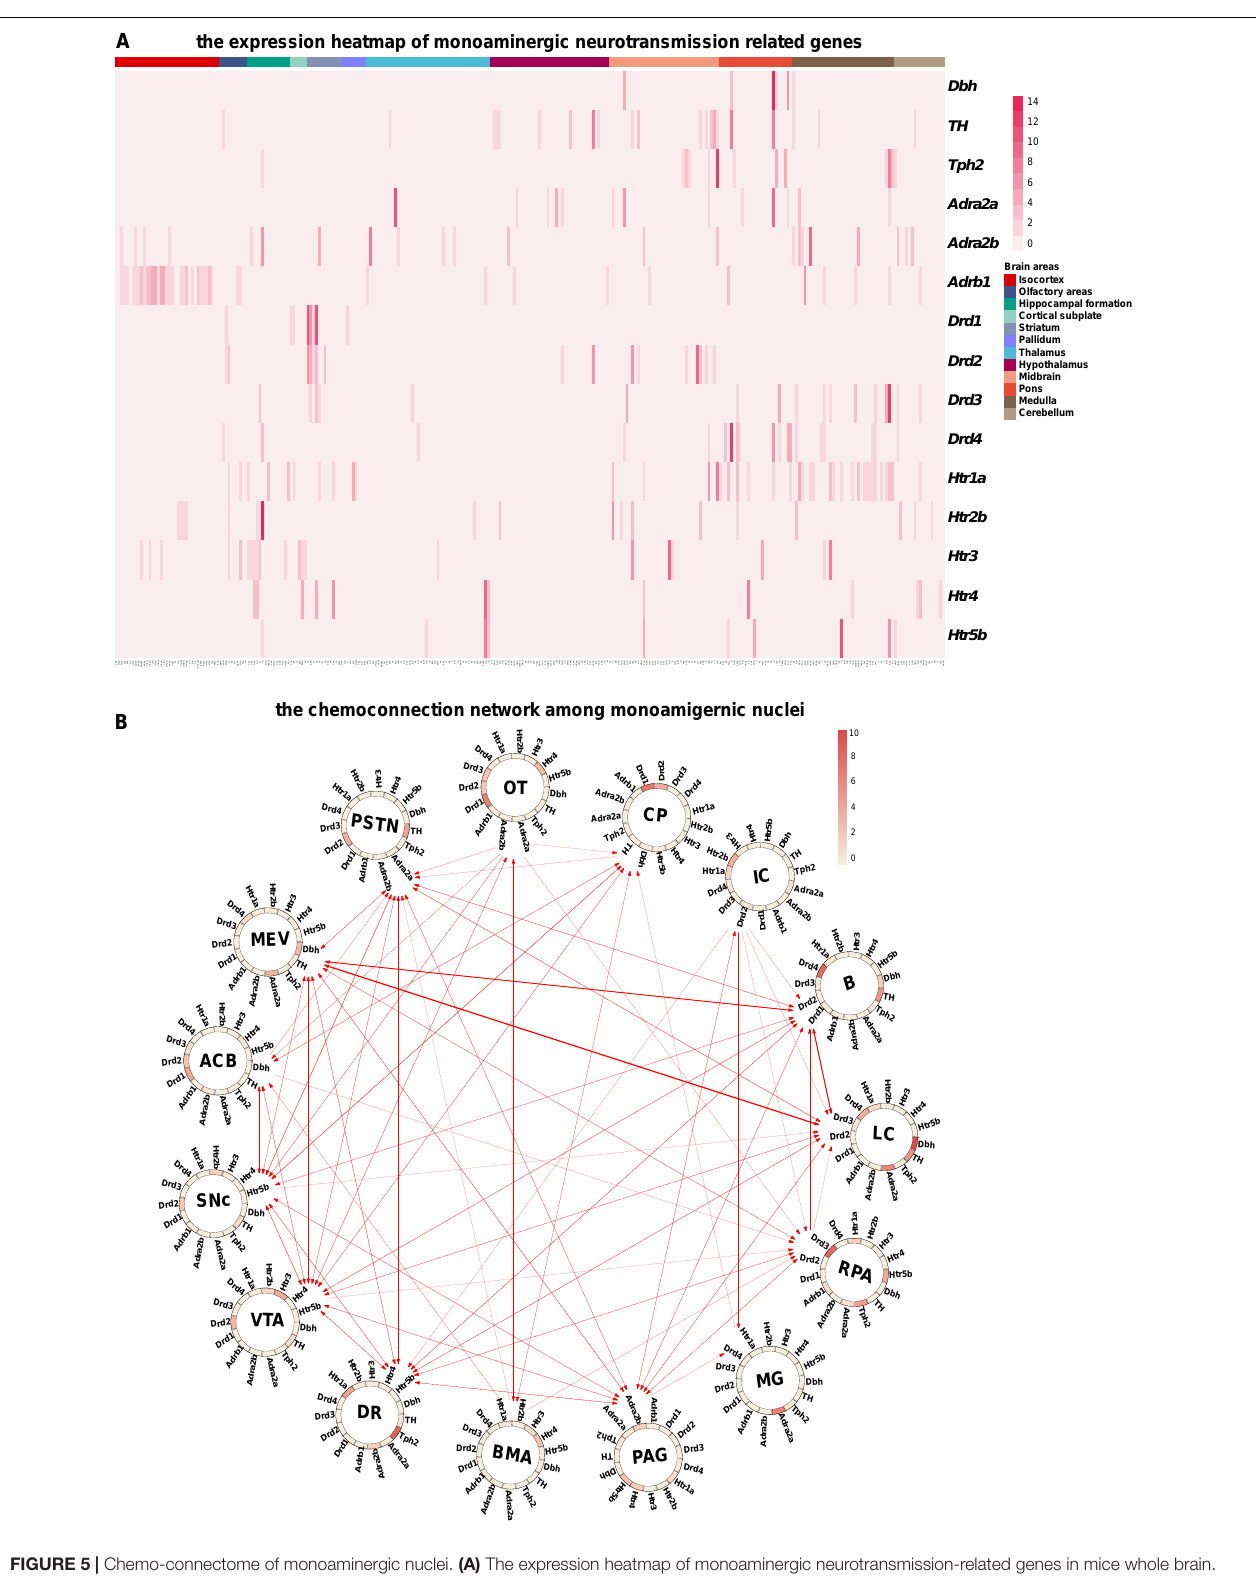
FIGURE 5 | Chemo-connectome of monoaminergic nuclei. (A) The expression heatmap of monoaminergic neurotransmission-related genes in mice whole brain. (B) The connectivity network and gene expression of monoaminergic nuclei were integrated to generate chemo-connection network. Arrows between the nuclei represent the projection direction, and the width of the line represents the projection intensity. The color in the circos diagram represents the expression density.